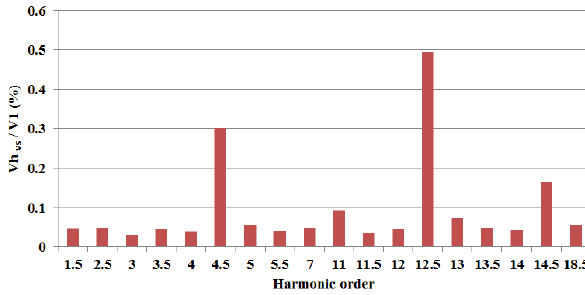
Figure 10. Individual 99th percentile very short time harmonic values at the PoC of the WPP base case